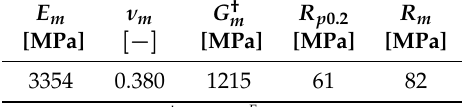
Table 6. Elastic properties and strength of RTM6-2 from H EXCEL R (cid:13) [46].